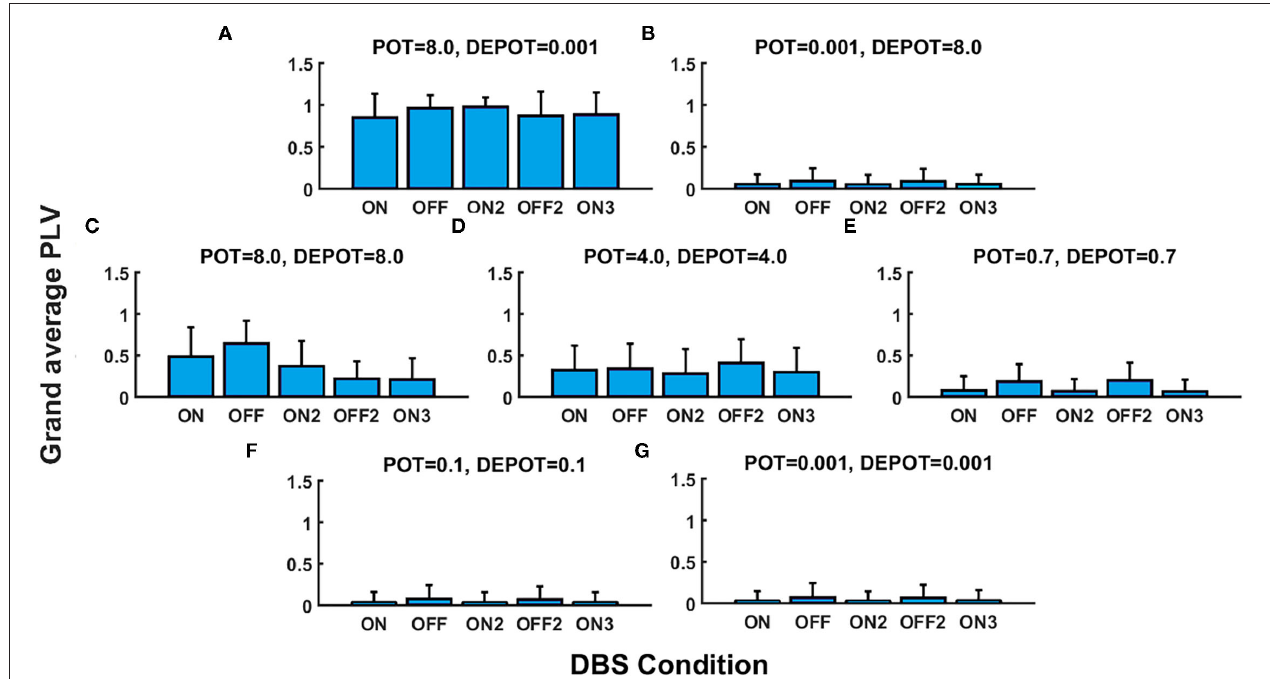
FIGURE 1 | The simulation results (mean and SD of the grand average phase locking value [PLV]) corresponding to the long-term effect of deep brain stimulation (DBS) under successive withdrawal and renewal of stimulation: unbalanced potentiation and depotentiation (high and low level) (A,B) ; balance potentiation and depotentiation, i.e., equally high levels, (C) ; equally medium levels (D) ; equally low levels (E–G) .